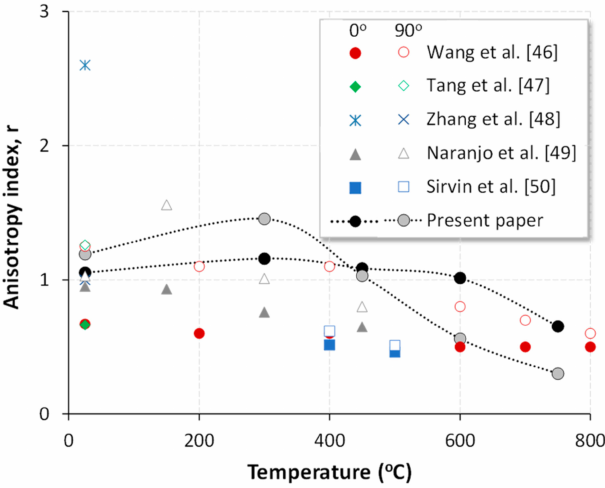
Figure 16. Ti6Al4V r-values obtained in this paper compared to those obtained by previous authors.